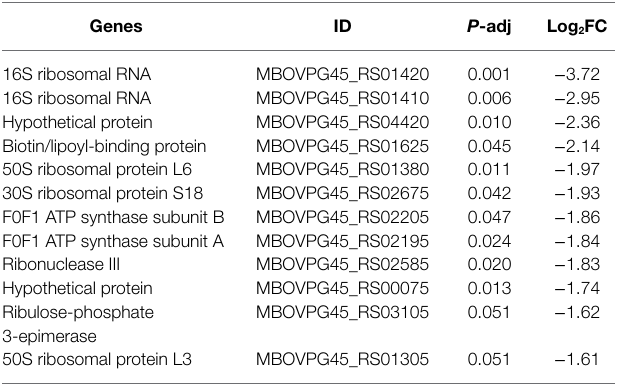
TABLE 4 | The 12 most upregulated genes after CAR treatment based on Log 2 FC.